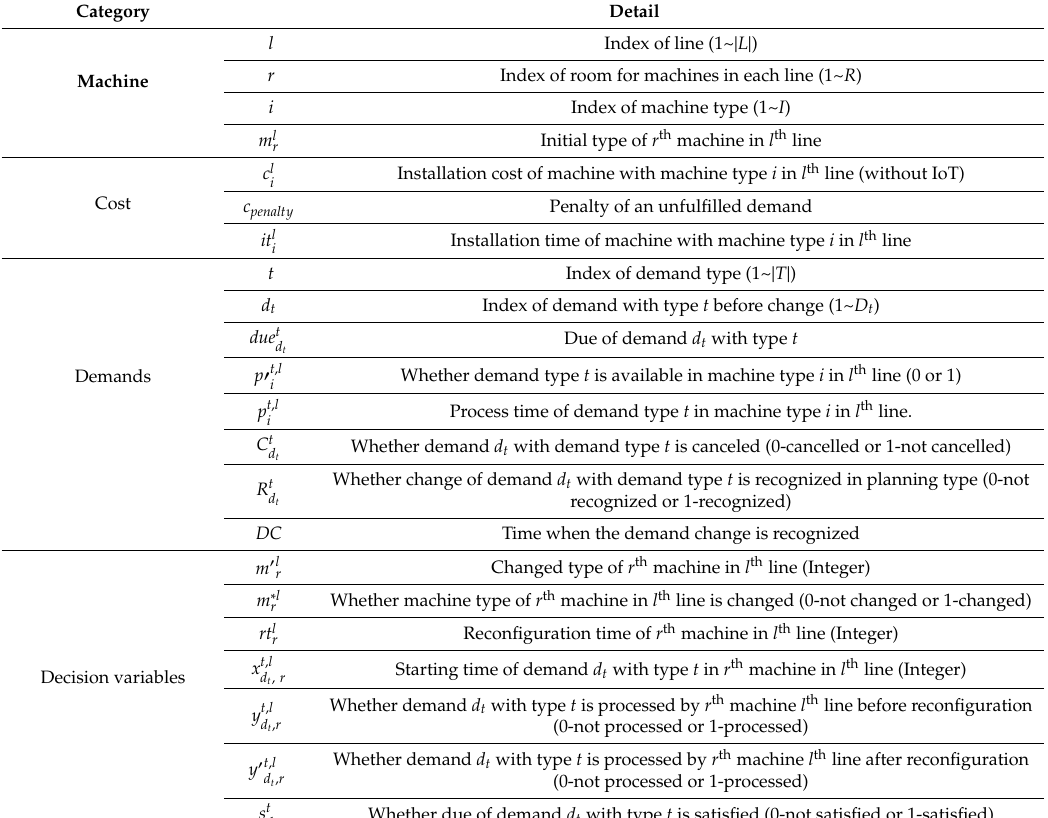
Table 3. Parameters and decision variables of integer